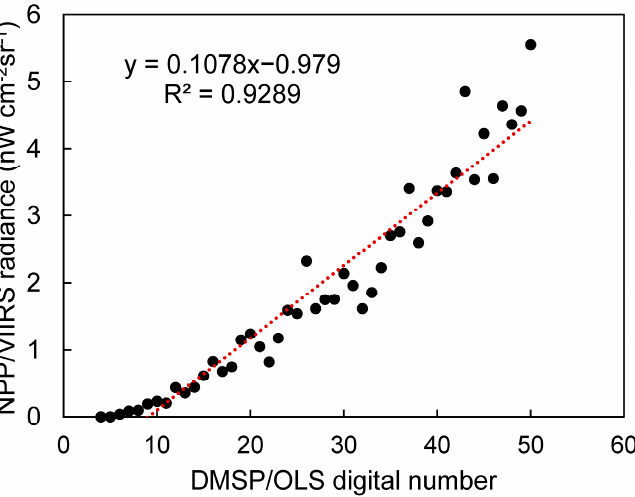
Figure 3. Correlation of DMSP-OLS with NPP-VIIRS in